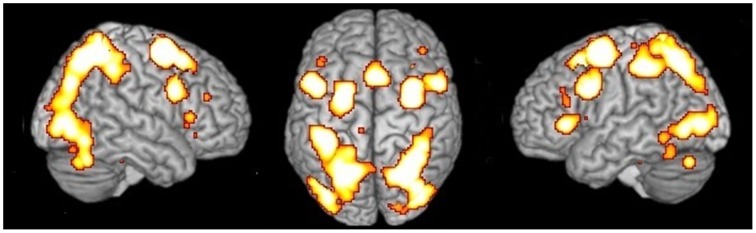
Network of activations underlying MR. Relative increases in neural activity associated with MR are displayed on a rendered template brain provided by spm5. Activations are significant at p < 0.05 corrected for multiple comparisons using the False Discovery Rate (FDR).